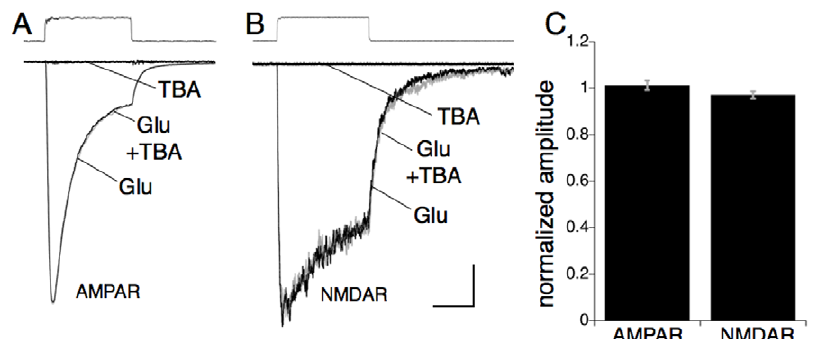
Figure 3. Representative recordings from outside-out patches excised from CA1 pyramidal neurons illustrating AMPAR and NMDAR responses to rapid application of 100 m M L-glutamate and/or 100 m M L-TBA for durations indicated by solution exchange traces above. Responses at 2 60 mV showing lack of agonist or antagonist actions of L-TBA on AMPARs (A; with 1.2 mM Mg 2 + ) and NMDARs (B; with 0 mM Mg 2 + /20 m M glycine/20 m M CNQX). Scale bars are 50/200 ms and 50/100 pA for AMPAR/NMDAR responses respectively. (C) Summary of mean